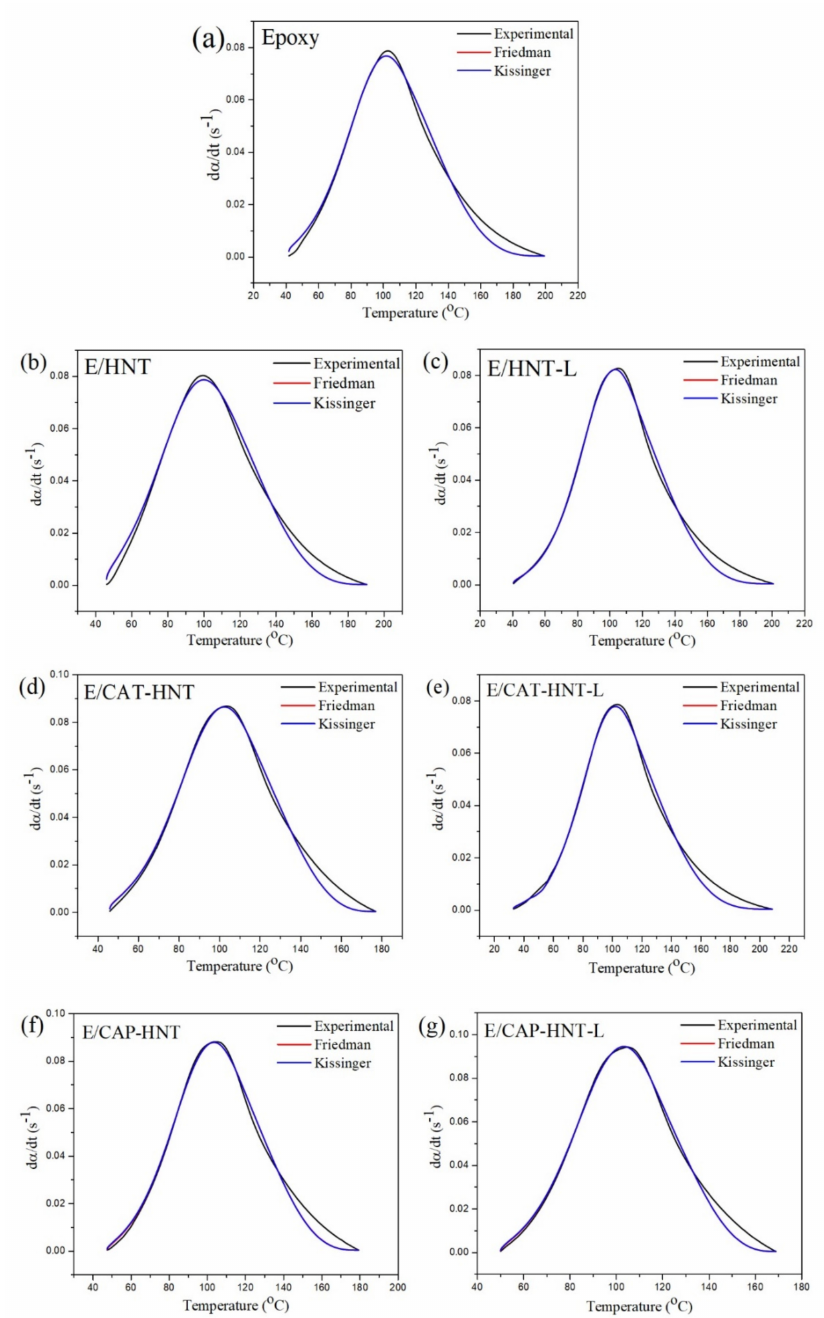
Figure 12. Predicted kinetics plots based on the n th order decomposition reaction model for neat epoxy ( a ) and its nanocomposites containing 0.1 wt.% amounts of HNT ( b ), HNT-L ( c ), CAT-HNT ( d ), CAT-HNT-L ( e ), CAP-HNT ( f ), and CAP-HNT-L ( g ), at the heating rate of 5 ◦ C · min − 1